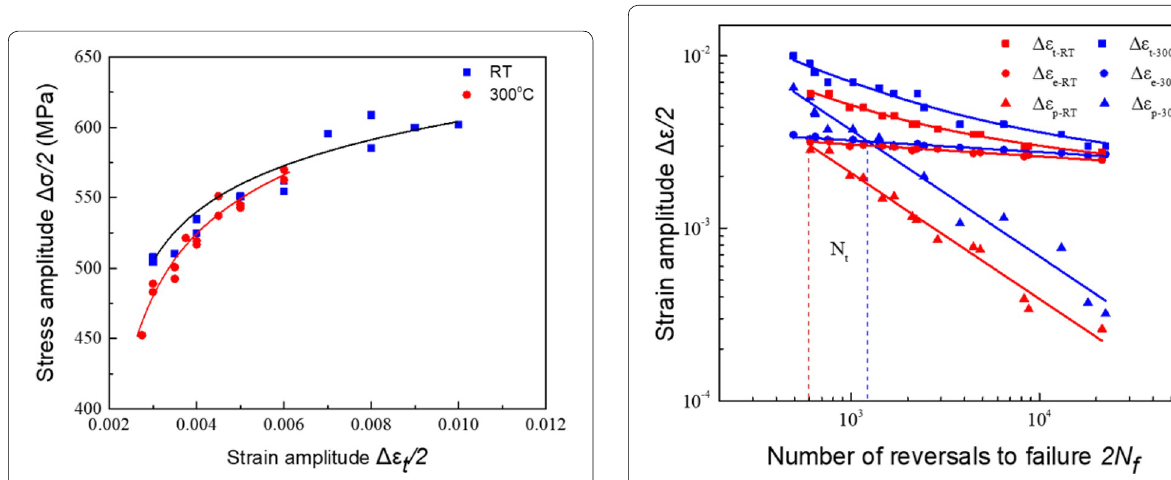
Figure 2 Cyclic stress-strain curves at different temperatures